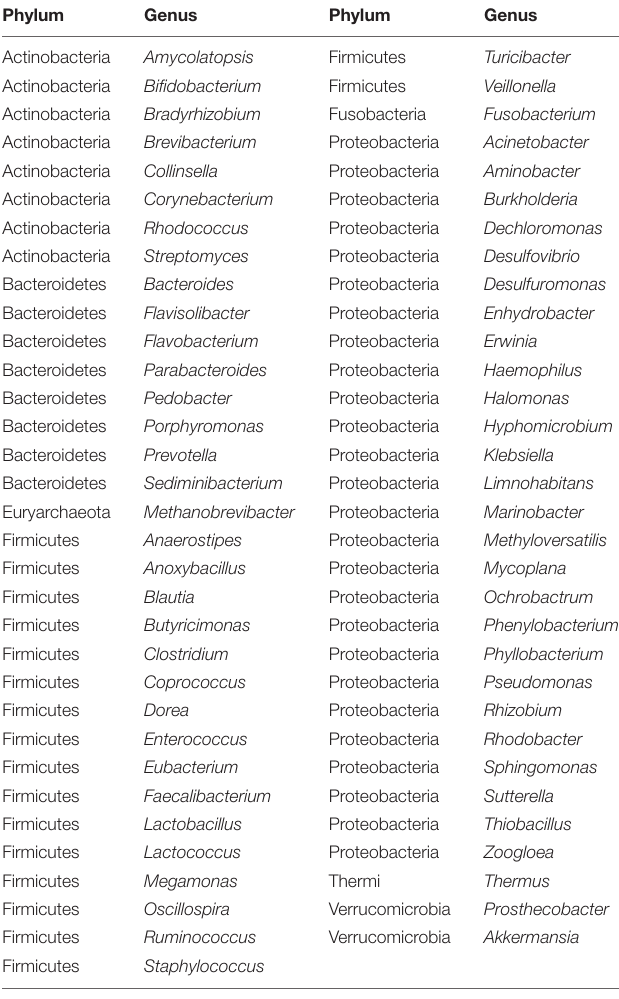
TABLE 2 | Sixty-five core microbes which were common to embryo, chick, and maternal hen in Venn